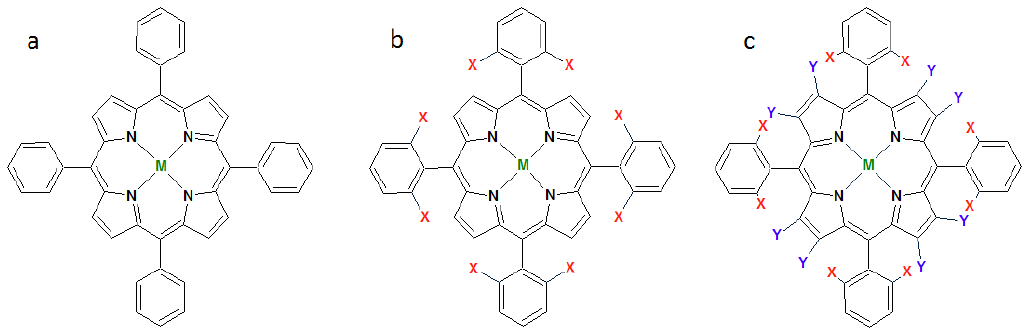
Figure 2. Metalloporphyrins of the ( a ) first, ( b ) second, and ( c ) third generation, where X represents an EWG or bulky group and Y is a halogen